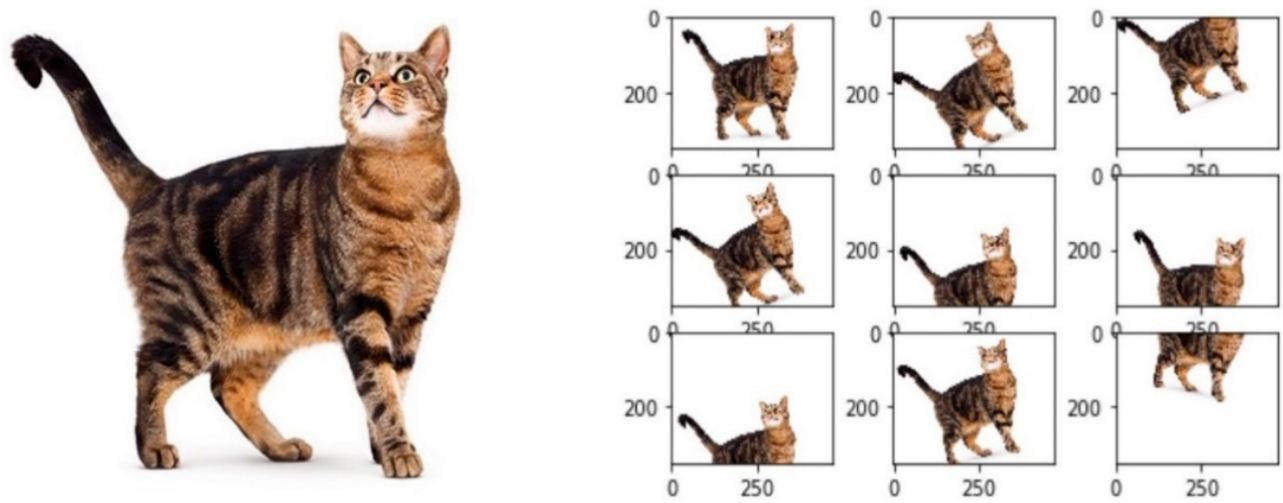
Figure 4. Original image with data augmentation [33].